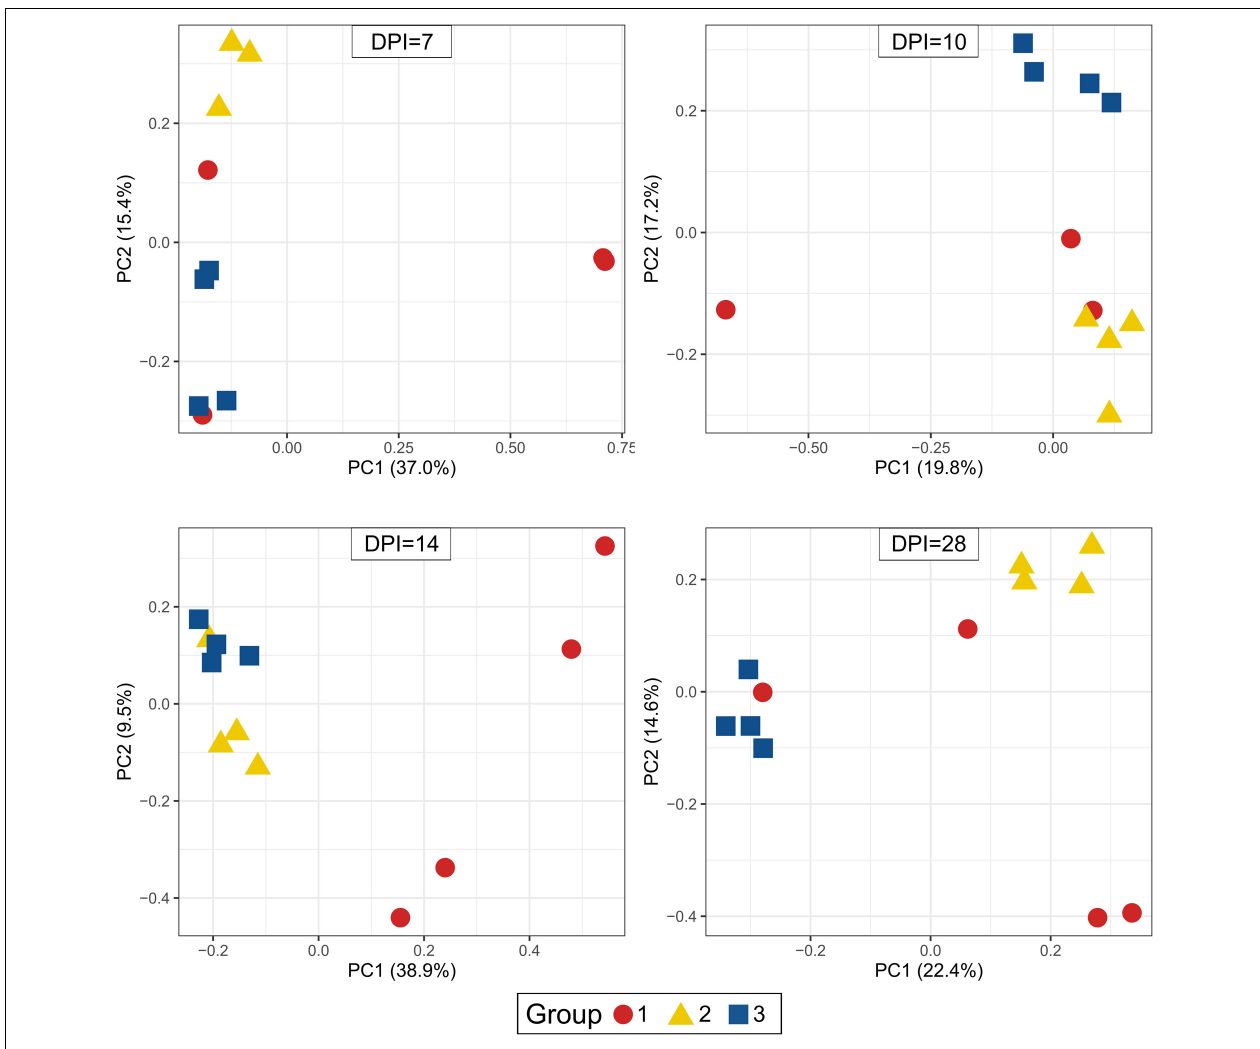
FIGURE 6 | Principal Coordinate Analysis (PCoA) of beta diversity using Bray-Curtis distances. Each dot corresponds to one bird. Group 1, infected with H. meleagridis + lux -tagged E. coli ; Group 2, infected with lux -tagged E. coli ; Group 3, negative control. dpi denotes for days post H. meleagridis